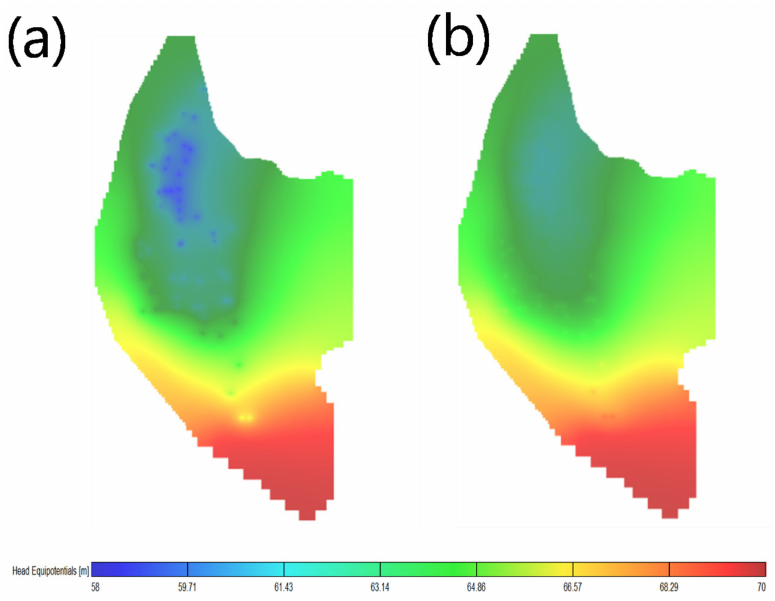
Figure 8. Spatial head distribution owing to ( a ) WCC and ( b ) at 100 days after artificial